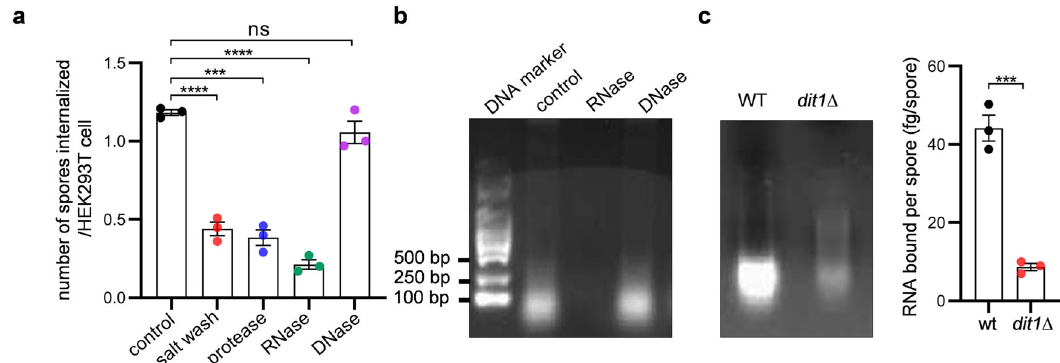
Fig. 2 RNA is attached to the spore wall. a Internalization of spores treated with indicated reagents in HEK293T cells. b Detection of RNA bound to the spore wall. Nucleic acids puri fi ed from high-salt eluate of spores were treated with indicated enzymes. These treated and untreated (control) samples were subjected to agarose gel electrophoresis and stained with a fl uorescent nucleic acid dye. A double-stranded DNA marker was used as a reference. c Left panel: Detection of RNA bound to wild-type (wt) or dit1 Δ spores. Right panel: Amount of RNA eluted from 2 × 10 8 of wild-type (wt) or dit1 Δ spores. Data were presented as the mean ± SEM ( a , c ). Statistical signi fi cance was determined by two-tailed unpaired Student ’ s t -tests. n = 3 ( a , c ). *** P < 0.001; **** P < 0.0001; ns not signi fi cant ( P ≥